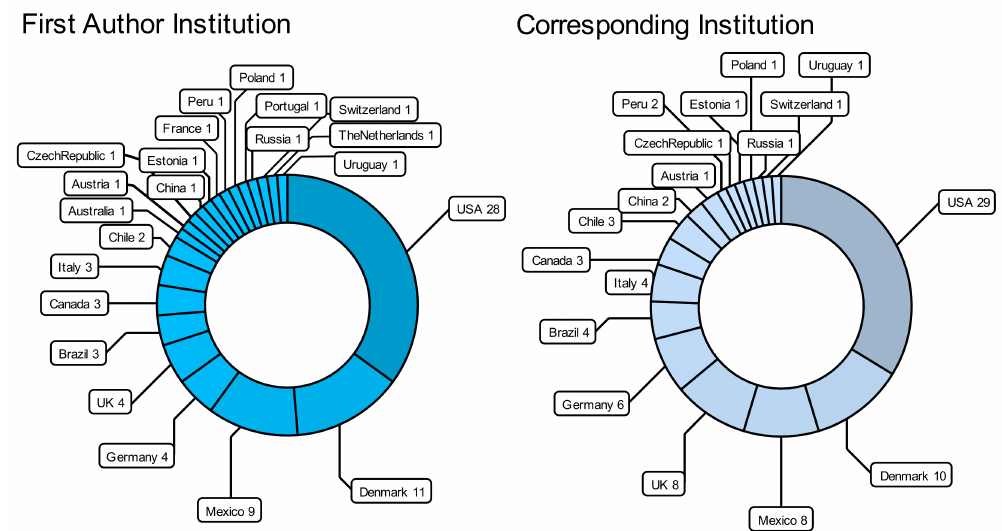
Figure 4. Country involvement in NatAm population genomic research. There is a lack of representa- tion of NatAm home countries as project